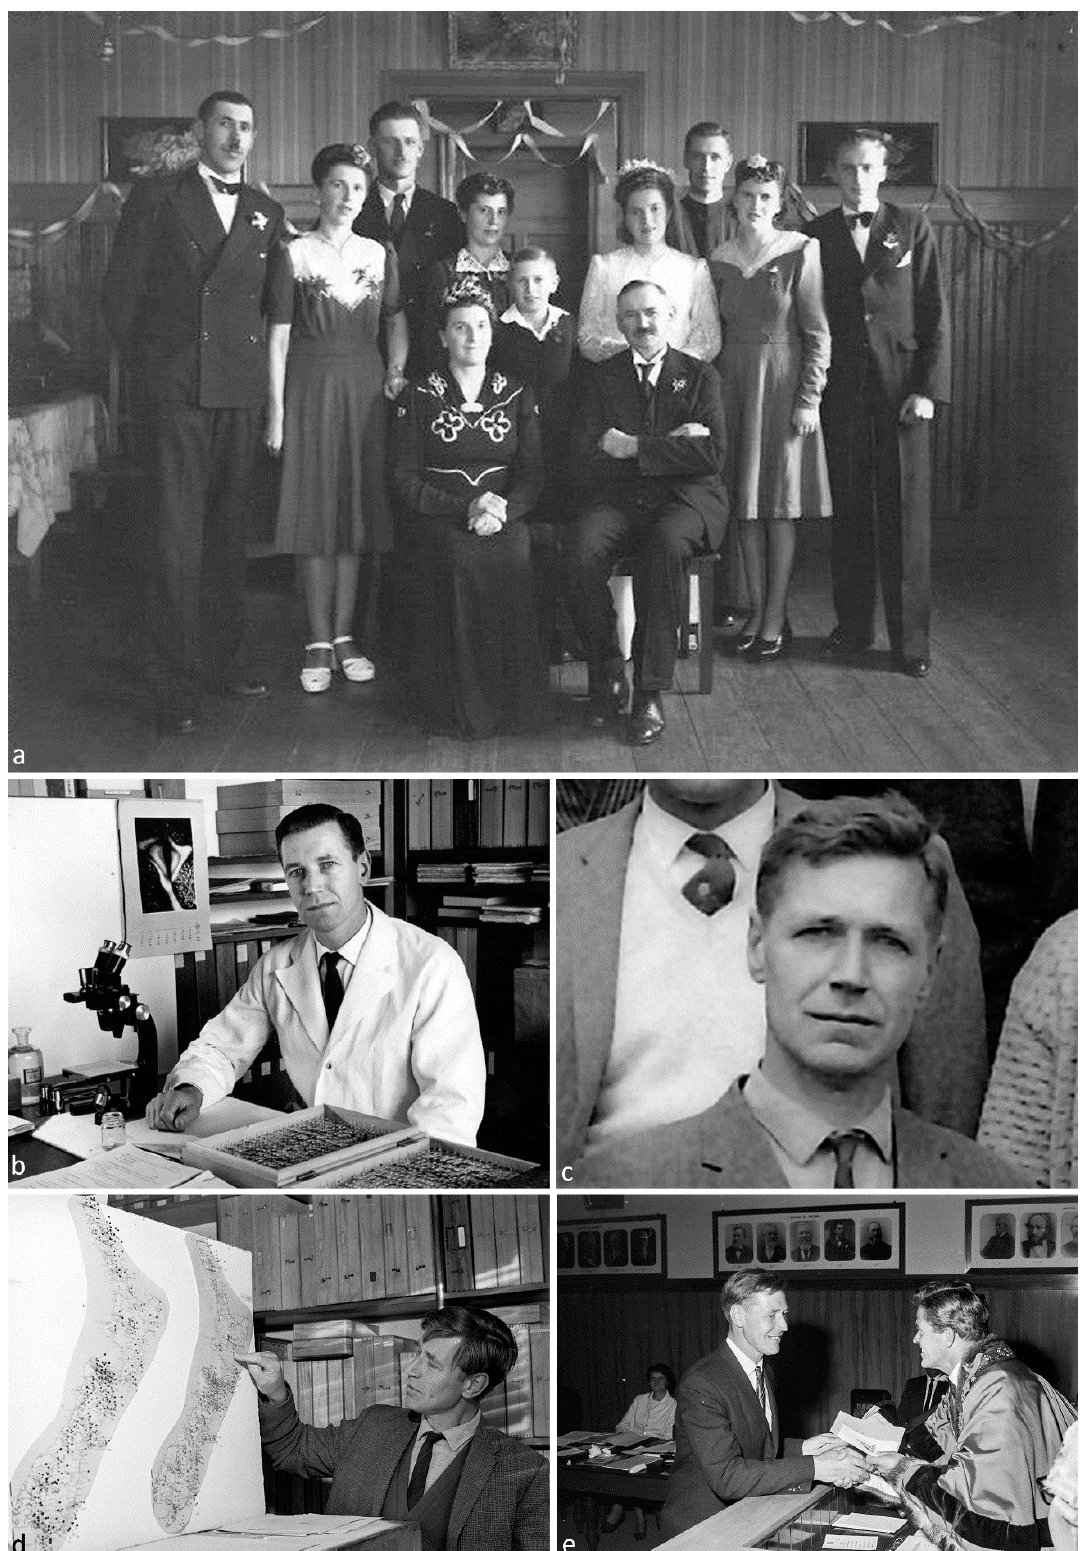
Figure 1. A portrait of Willy Kuschel: ( a ) with parents (Clara Neumann Wittwer and Germán Pedro Kuschel Kruse; seated) and siblings (f.l.t.r. Alberto, Clara, Arnoldo, María, Oscar, Olga, Guillermo, Adela, Evaldo) at parents’ Silver Wedding anniversary, Frutillar, Chile, February 1945; ( b ) at time of reception of Linnaeus medal, 1962; ( c ) on D.S.I.R. staff photo, Entomology Division, Nelson, 1967; ( d ) indicating areas on New Zealand’s South Island for further sampling, June 1969 (© NPN); ( e ) receiving his New Zealand citizenship papers from the Mayor of Nelson, April 1969 (© NPN).